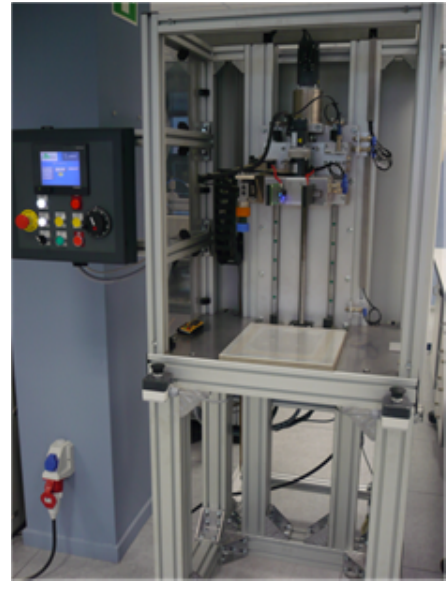
Figure 9. Load cell pressure characterization platform.